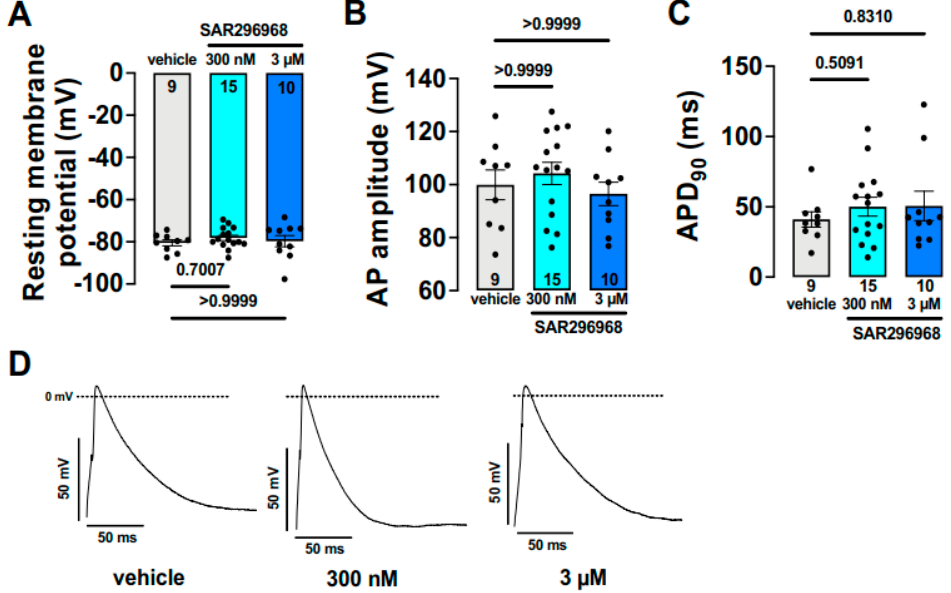
Figure 7. Effect of SAR296968 on human atrial action potentials. Bar graphs ( A – C ) and original recordings ( D ) indicate no effect of NCX inhibition on action potential duration.